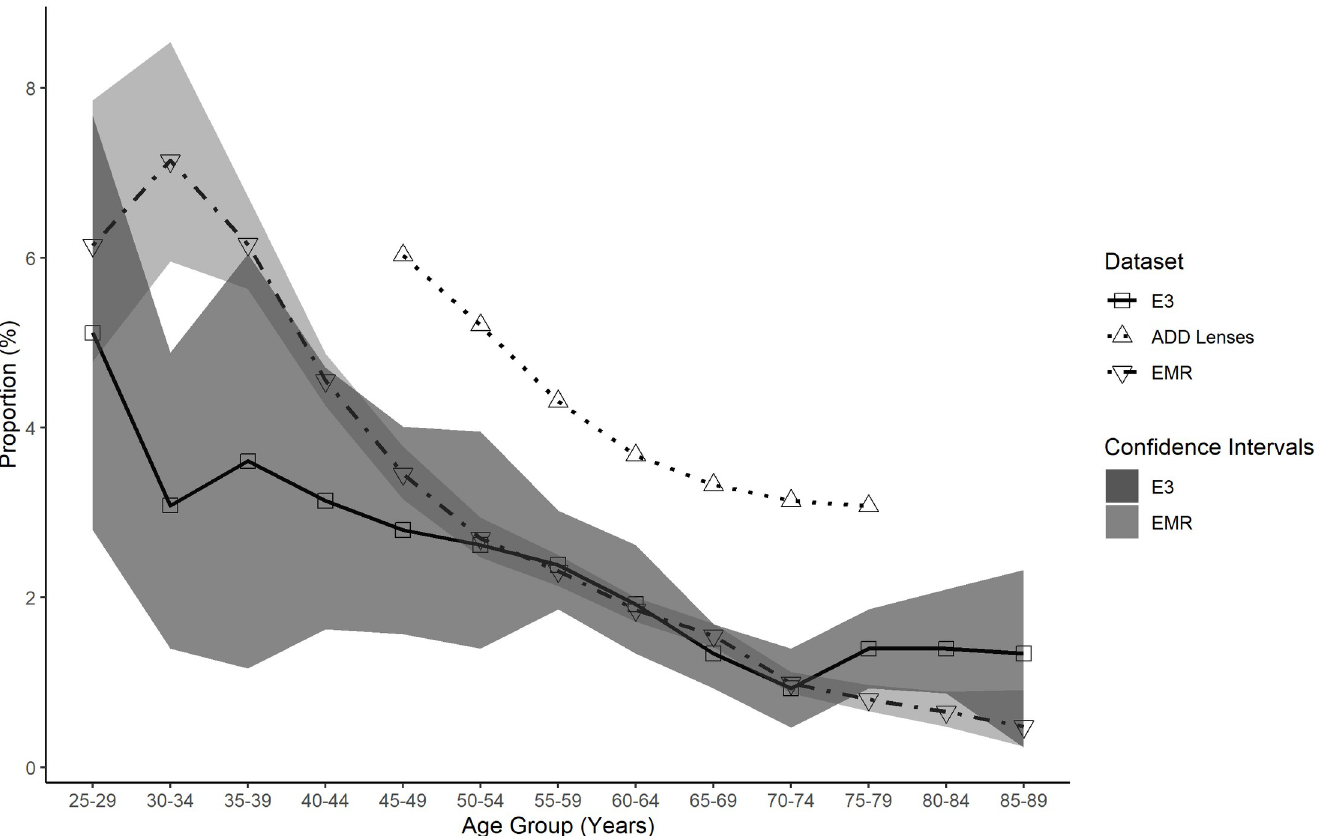
Fig 9. Total high myopia proportion for all data sets as a function of age group. Total high myopia proportion for EMR (inverted triangle), ADD Lenses (triangle) and E3 (square) data as a function of age group. The E3 data confidence intervals (dark shaded area) are plotted to illustrate comparison with the other data sets. The EMR data confidence intervals (light shaded area) are plotted to show the overlap with the E3 data. GHS not present as high myopia data was unavailable.